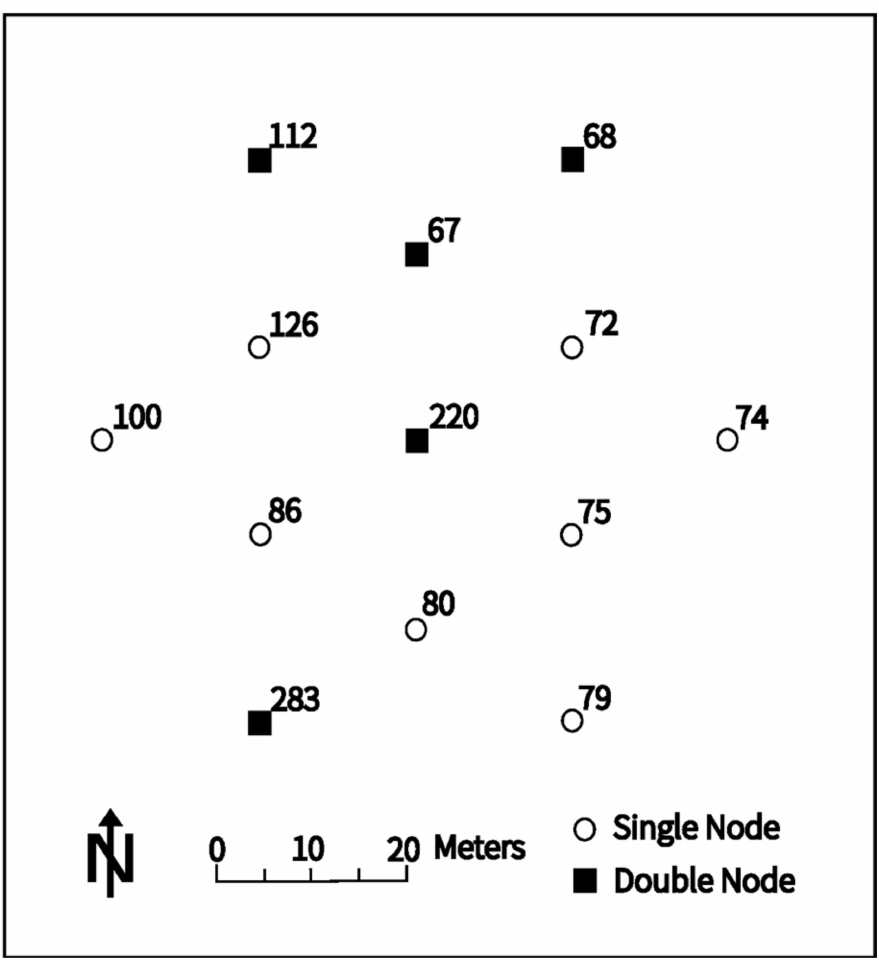
Figure 2. Schematics of the distribution of the nodes at the wireless sensor network used in this study at the Santa Rosa National Park—Environmental Monitoring Super Site (SRNP-EMSS), Guanacaste, Costa Rica. Black square nodes (112, 68, 67, 220 and 283) have co-located PAR nodes. Empty white circles (72, 74, 75, 79, 80, 86, 100, and 126) have just one PAR